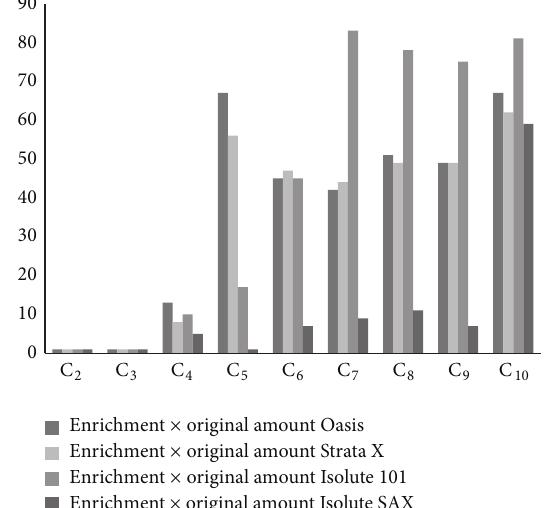
Figure 4: Comparison of the performance enrichment of SPE materials in extraction of the C 2 –C 10 DCAs. The DCA concentration is 5 mg/L. The results are averages of six replicates. Analysis conditions as described in Experimental and in Figure